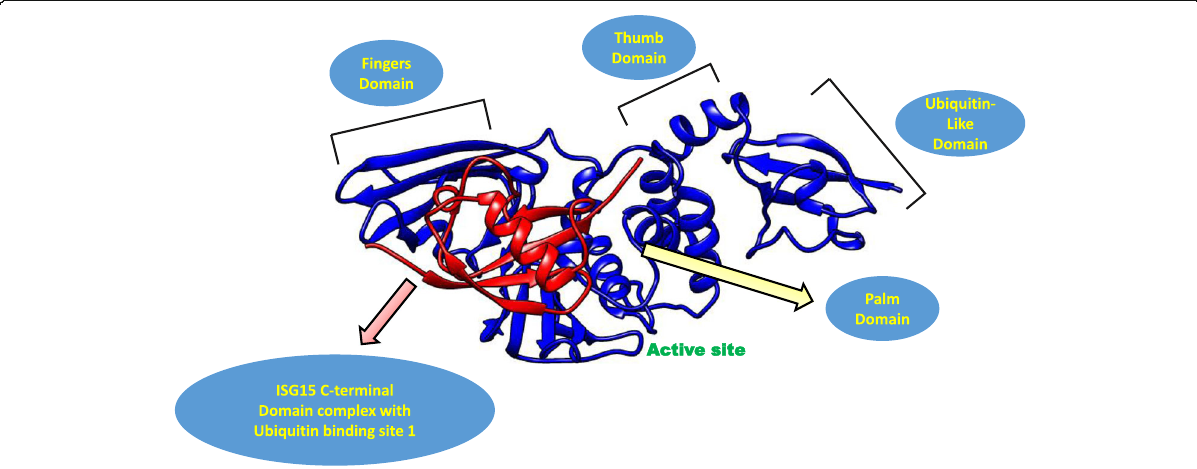
Fig. 3 Interactions between the C-terminal domain of interferon-stimulated gene 15 (ISG-15) and SARS-CoV-2 wild-type papain-like viral proteases. The red chain is the C-terminal domain of ISG-15. The blue chain represents the